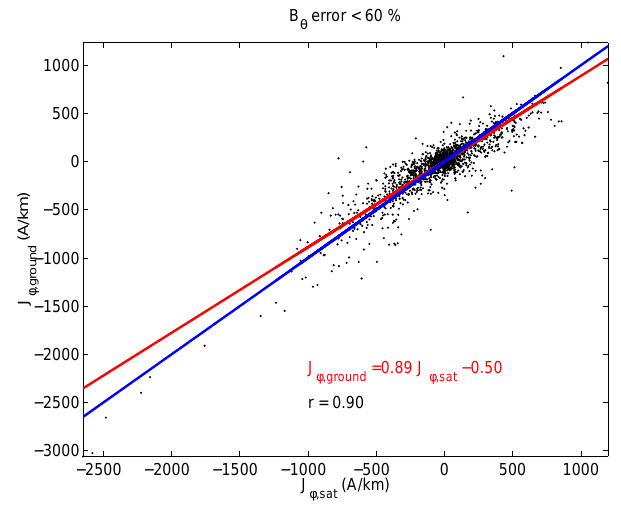
Fig. 5. Scatter plot of J φ determined from ground-based measurements (IMAGE) by the 2D SECS method with respect to J φ determined from satellite-based measurements (CHAMP) by the 1D SECS method. The ground-based J φ is averaged over the approximately four minutes it takes for the satellite to pass over IMAGE. In red is shown a line fitted to the points, and the linear correlation coefficient is denoted by r . A line passing through the origin with a unit slope is drawn in blue. To create this plot, data from 124 satellite passes over IMAGE with an error smaller than 60% during 2001 and 2002 were used.